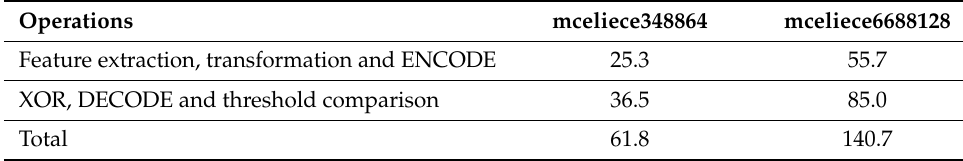
Table 3. Execution times (ms) for the authentication operations.